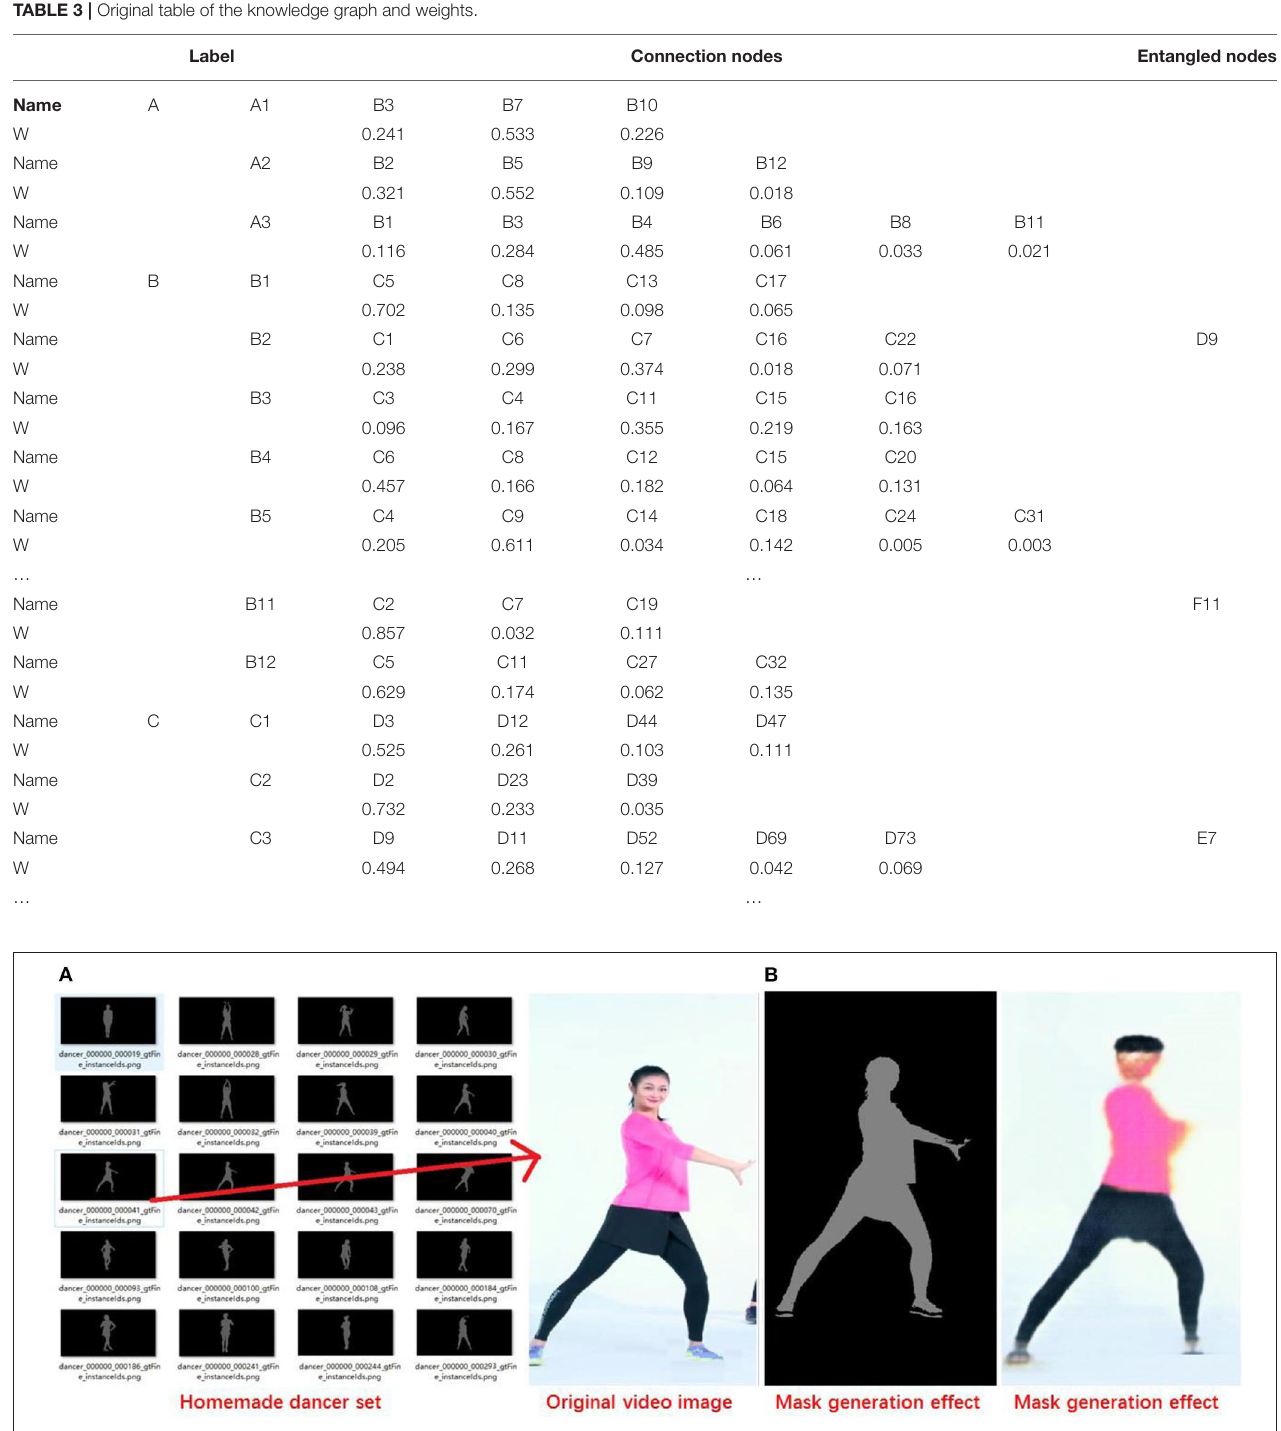
errors in the measurement data have been prevented. Similarly, the information entropy of a complex system is calculated through the change in information volume of the